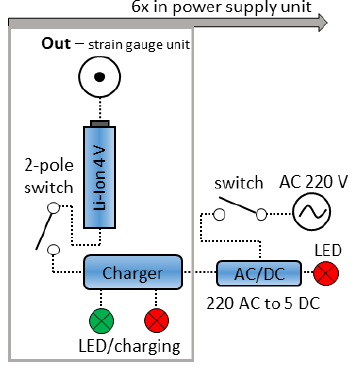
Figure 4. Battery power supply solution scheme.